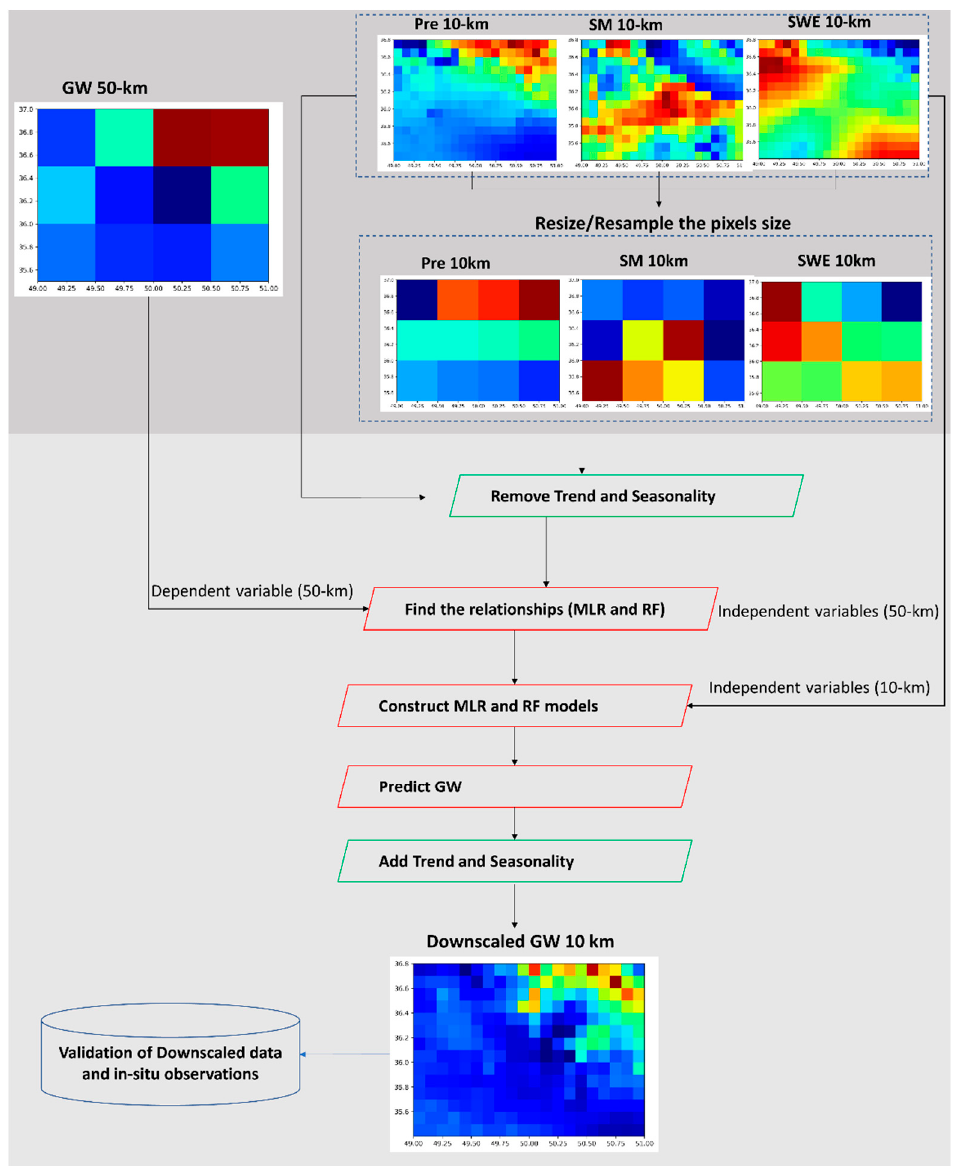
Figure 3. Schematic view of the workflow of the method.